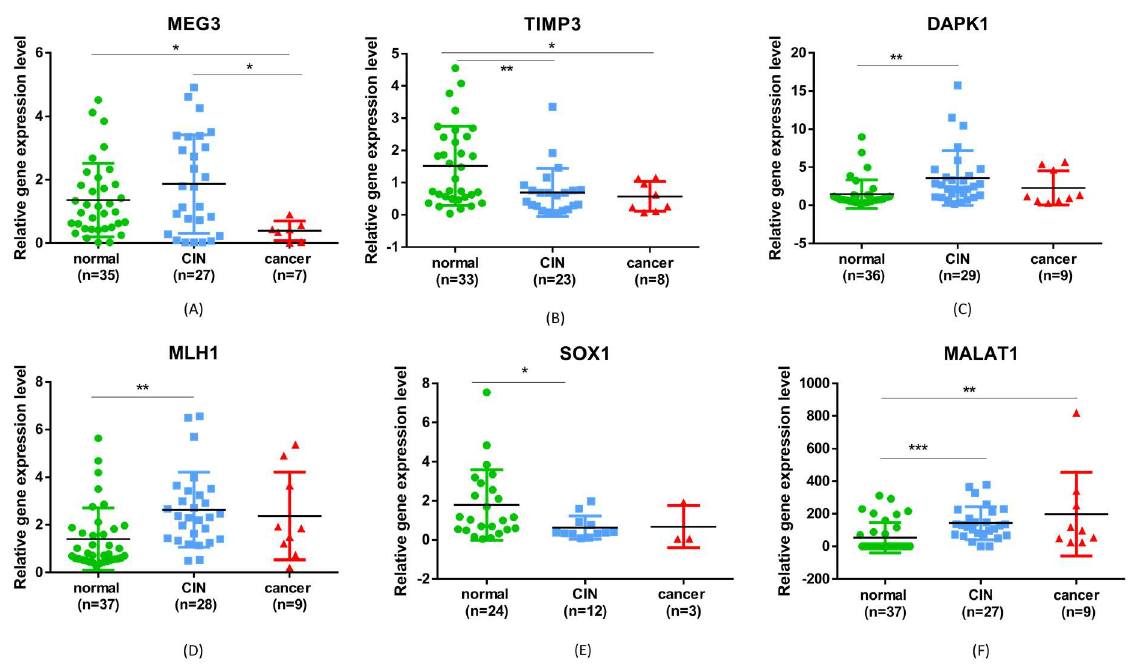
Figure 4. Expression levels of ( A ) MEG3, ( B ) TIMP3 , ( C ) DAPK1 , ( D ) MLH1 , ( E ) SOX1 and ( F ) MALAT1 for normal, cervical intraepithelial neoplasia (CIN) and cancer samples. (* p ≤ 0.05, ** p ≤ 0.01, *** p ≤ 0.0001).